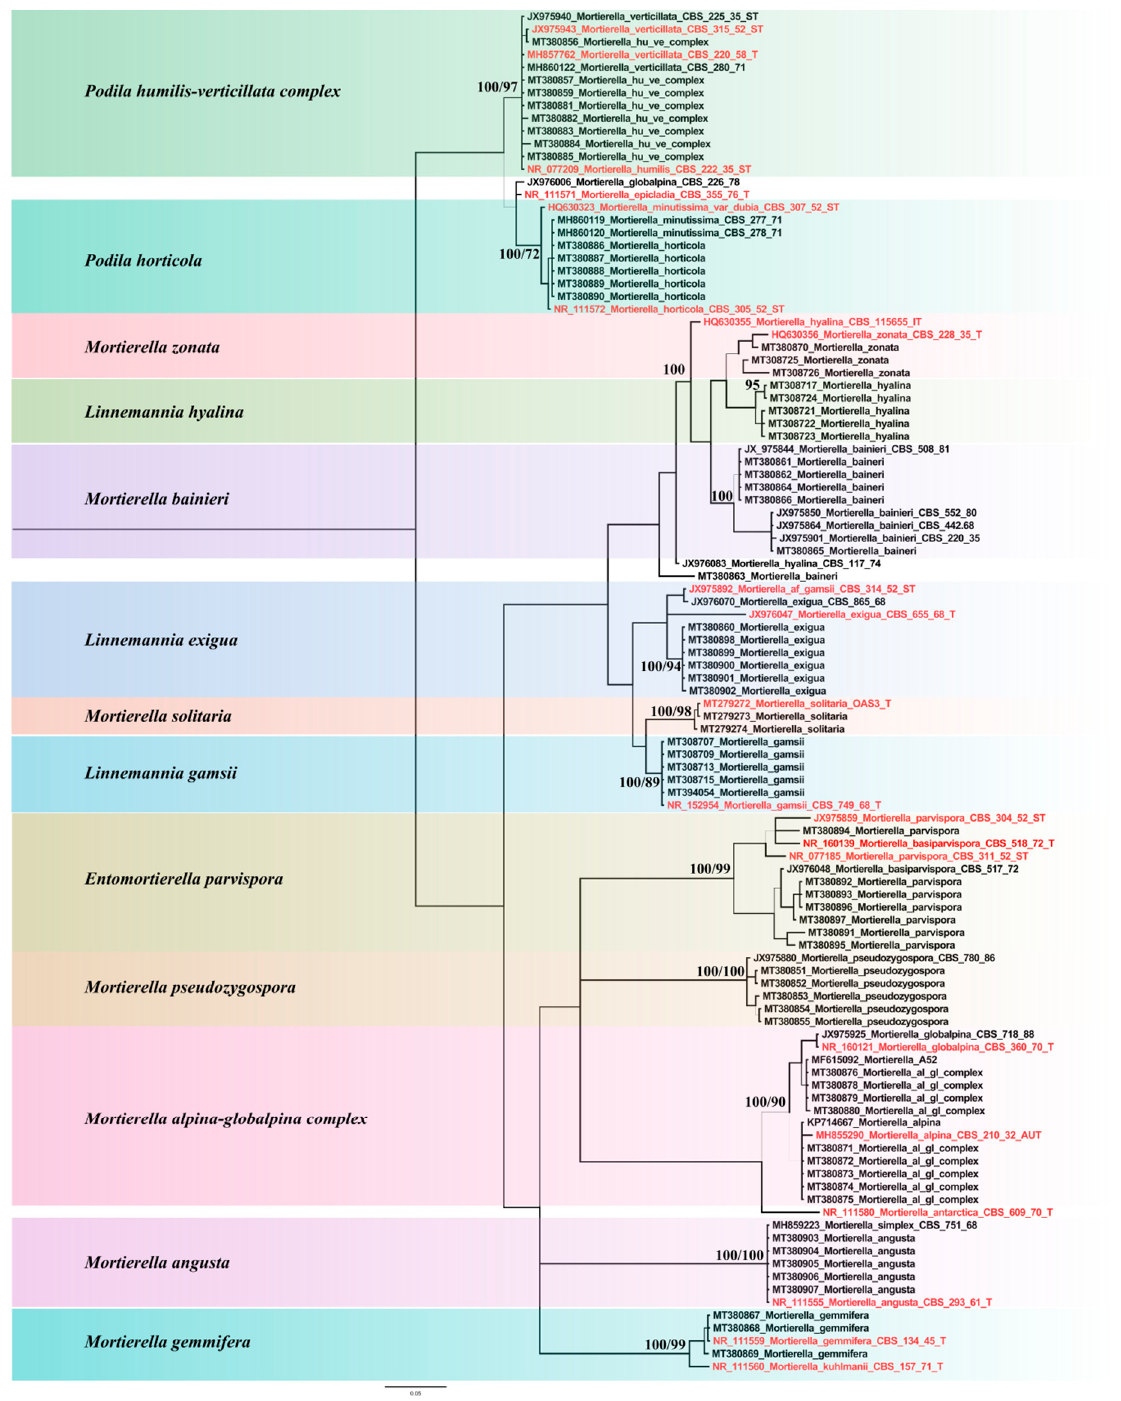
Figure 1. Phylogeny of the Mortierella s. l. species included in the VOC analysis. The 72 pure culture strains fall into 13 well-supported clades. Maximum Likelihood phylogram (log likelihood—1974.28) based on ITS sequences. Branch support (Bayesian posterior probabilities/Parsimony Bootstrap support ≥ 70) is shown above the respective branches. Sequences generated from type specimen are highlighted in red.